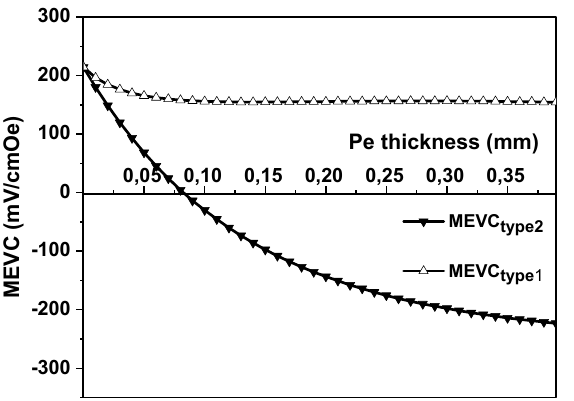
Figure 11. Estimated dependence of MEVC in Ni-PZT-Pe first-type and Ni-Pe-PZT second-type three-layered structures on the Permendur layer thickness. The PZT layer thickness t p = 0.2 mm, the Ni thickness t m 1 = 0.2 mm.